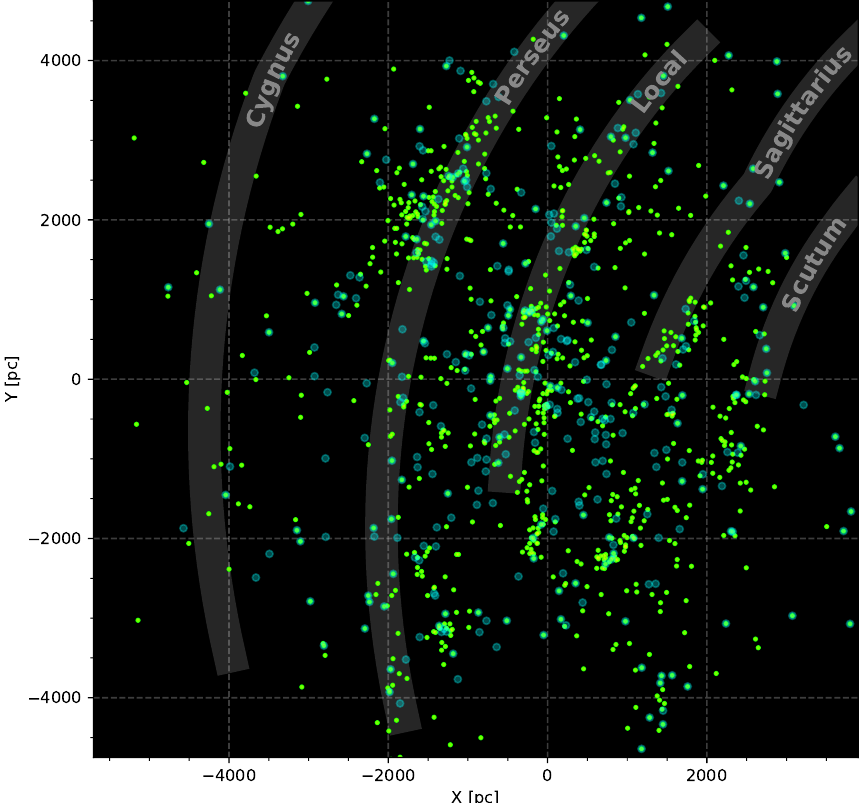
Figure 3. Distribution of all clusters from Cantat-Gaudin et al. [72] and Castro-Ginard et al. [73] younger than 60Myr (green) and between 60 and 100Myr (blue), projected on the Galactic plane. The trace of the spiral arms is the model of Reid et al. [90], which was obtained with VLBI trigonometric parallaxes of high-mass star-forming regions. The Sun is located at